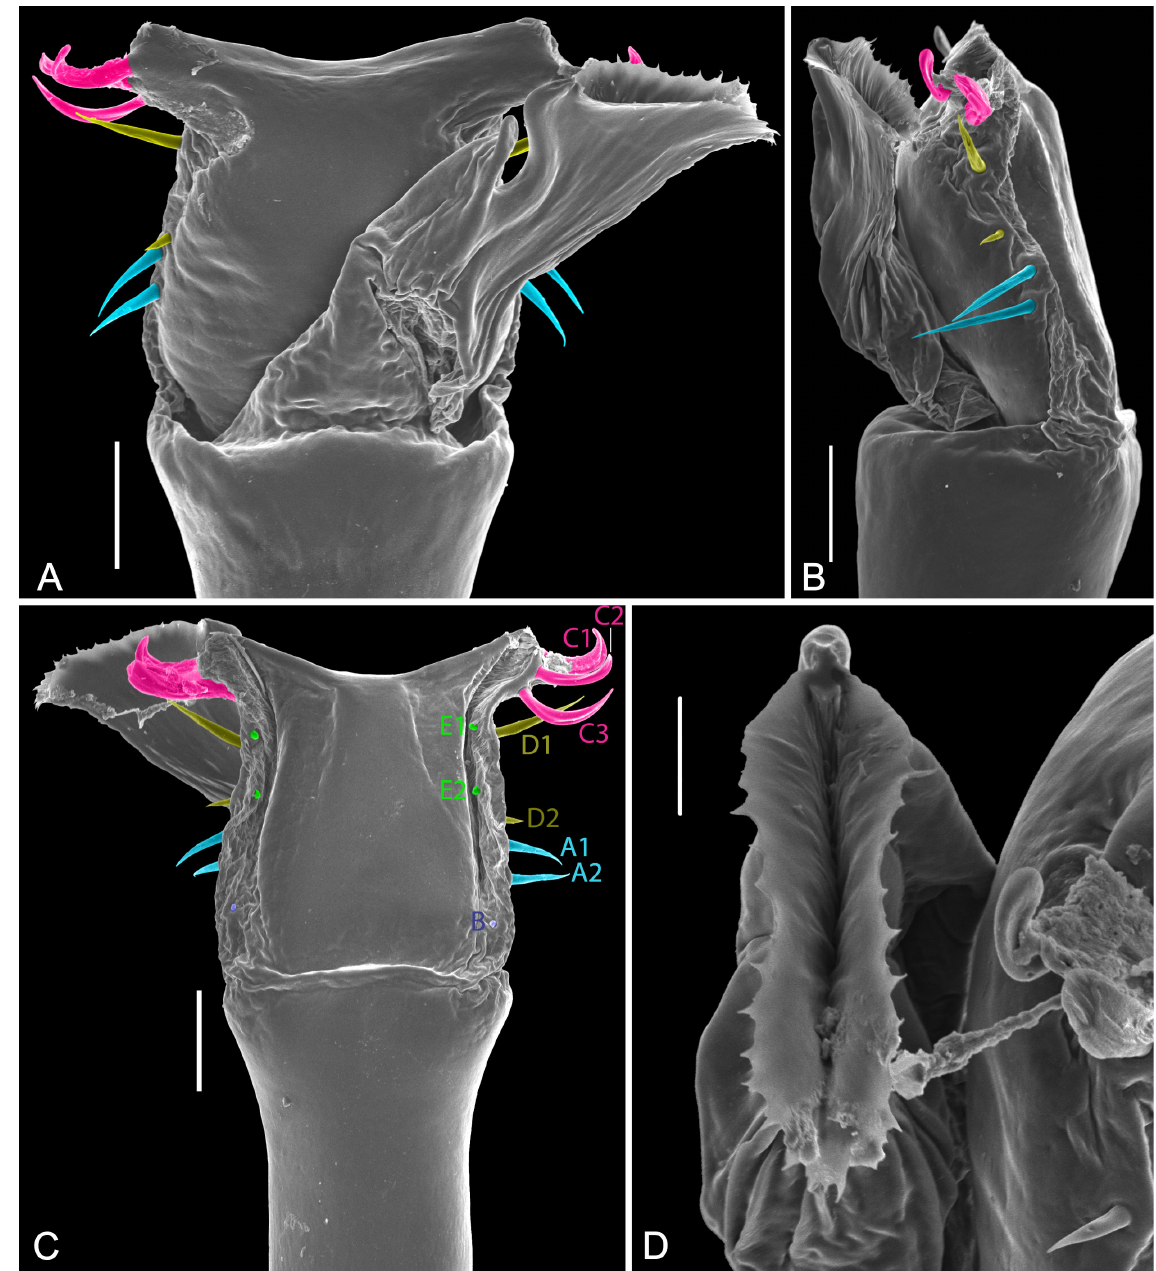
Fig. 4. Libitia bipunctata Sørensen, 1932, ♂ (ICN-AO 419), distal part of penis. A . Dorsal view B . Right lateral view. C . Ventral view, macrosetae colorised and numbered. D . Stylus, dorsal view. Scale bars: A–C = 50 μm; D = 20